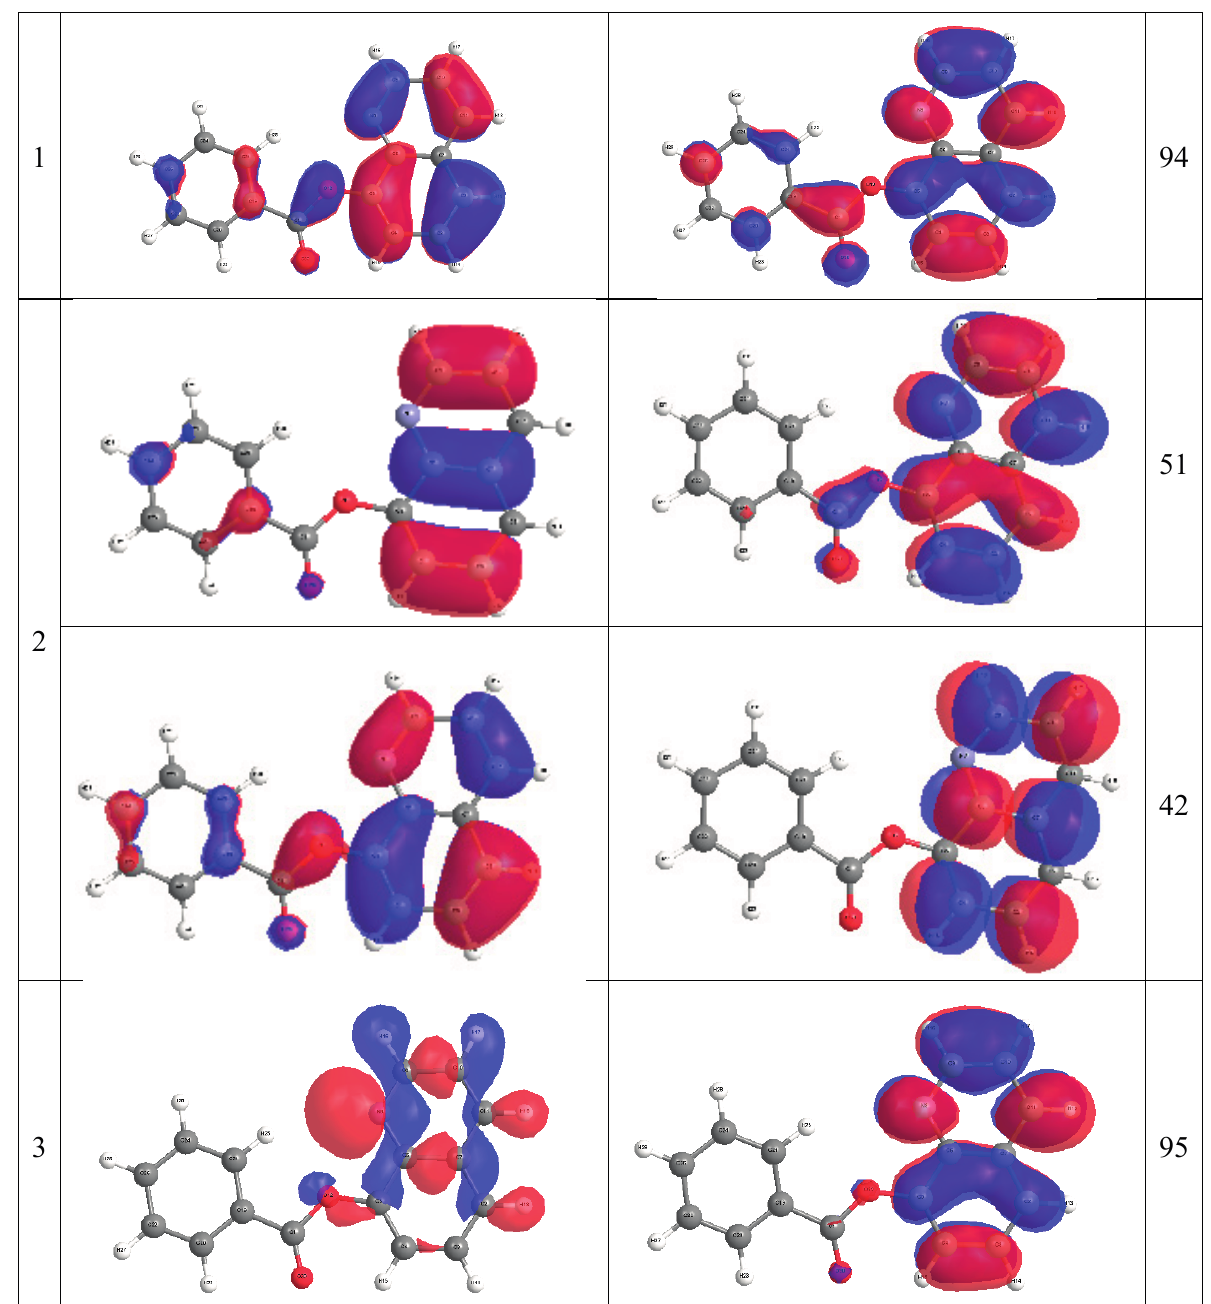
Figure 5. Natural Transition Orbital (NTO) for 8-OateQ-anti compound at CAM-B3LYP/6-311++G** level of